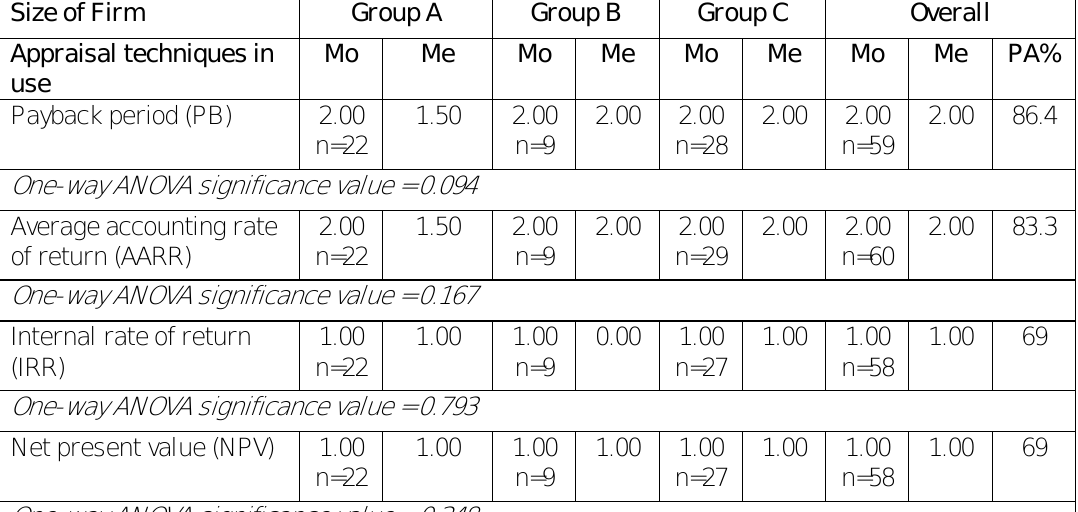
Table 2: Comparisons of usage of investment appraisal techniques Size of